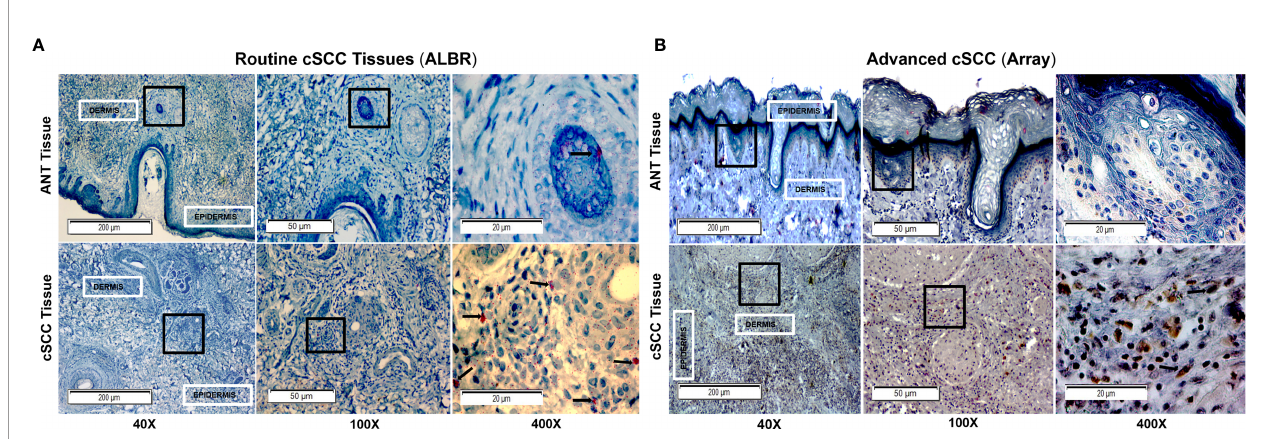
FIGURE 6 | FOXP3 in Routine Mohs and Advanced cSCC Samples by IHC. cSCC removed from routine clinic patients by Mohs surgery [ fi xed after cryosectioning; (A) ] and an array of advanced cSCC [formalin fi xed; (B) ] were labeled with a rabbit monoclonal anti-FOXP3 (Cell Marque) and stained with an HRP-conjugated secondary antibody and DAB stain (for Array samples) and with an AP-conjugated secondary antibody and permanent red stain (for ALBR samples). Mayer ’ s Hematoxylin was used as a counterstain (nuclei). The degree of FOXP3 staining in the ANT and cSCC samples was semi-quantitatively determined by using a 0-3+ scale, with 0 indicating no staining, 1+ indicating <10% staining, and 2+ indicating 10-50% staining, and 3+ indicating >50% staining. ANT samples [ (A, B) , top panels] were scored as 0, the Mohs cSCC samples [ (A) , bottom panel; arrows in the 400x image denote positive nuclear localization] were scored as 1+, and the advanced cSCC samples [ (B) , bottom panel; arrows in the 400x image denote positive nuclear localization] were scored as 2+. The boxes within the 40x and 100x images delineate the tissue location shown in the 100x and 400x images,